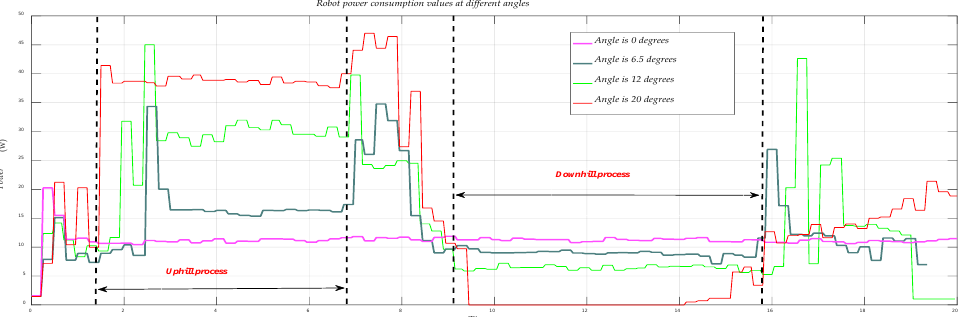
Figure 8. Power consumption during robot movement.